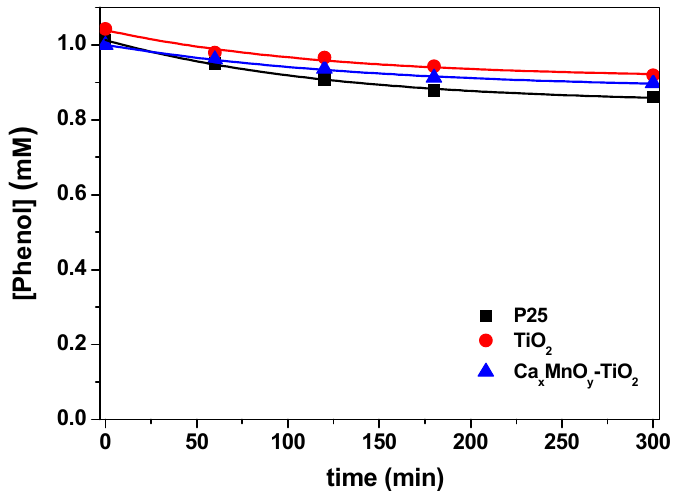
Figure 7. Change in phenol concentration over time upon photocatalysis under UV-Vis irradiation in the presence of TiO 2 -P25, TiO 2 -Hombikat UV100 and Ca x MnO y -TiO 2 .